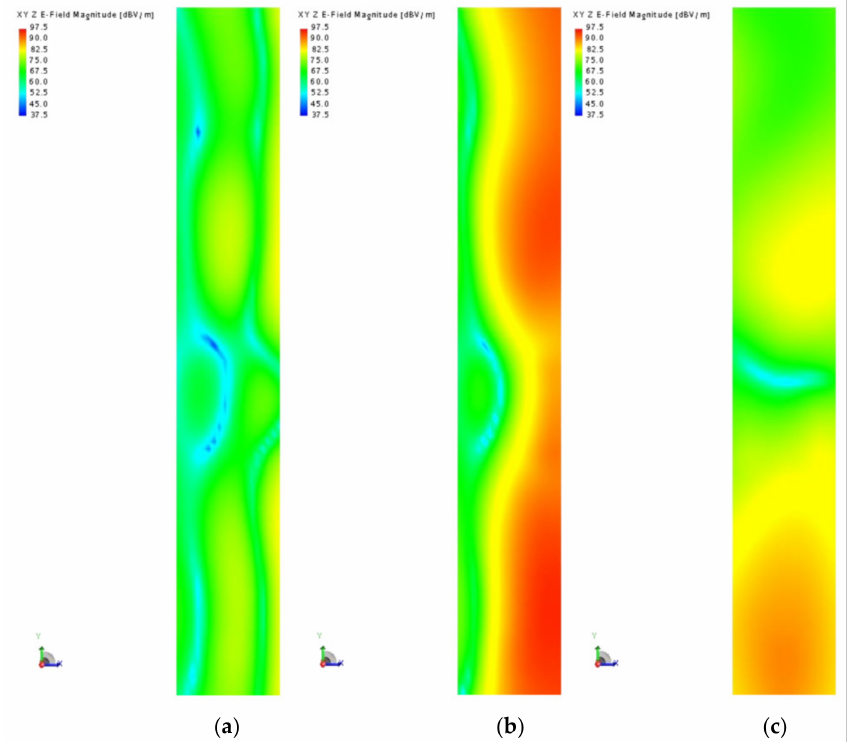
Figure 12. Electric field strength distribution E ( t ) of bottom layer with different time t . ( a ) t = 0 ns, ( b ) t = 10 ns. ( c ) t = 100